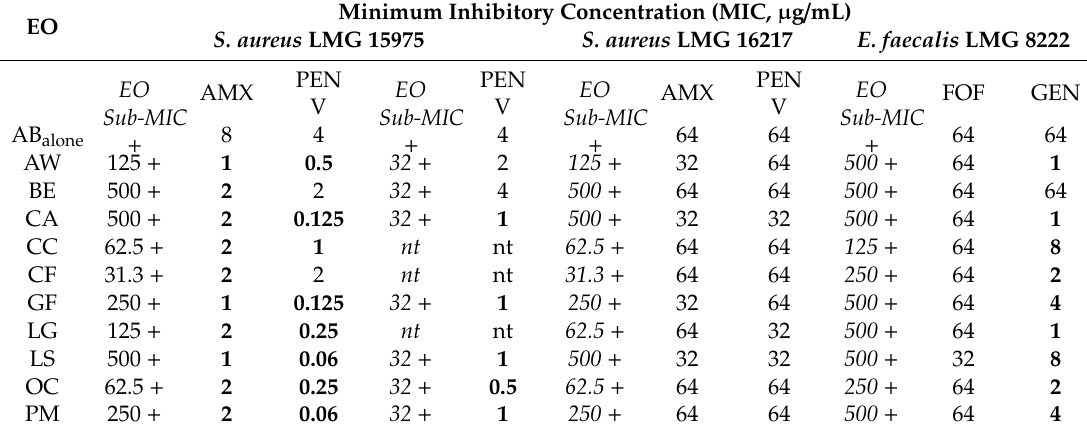
Table 6. Indirect activity of the essential oils, combined at a non-active concentration (sub-MIC) with antibiotics, against the two MRSA and E. faecalis ( n = 3). In bold, the most promising results.